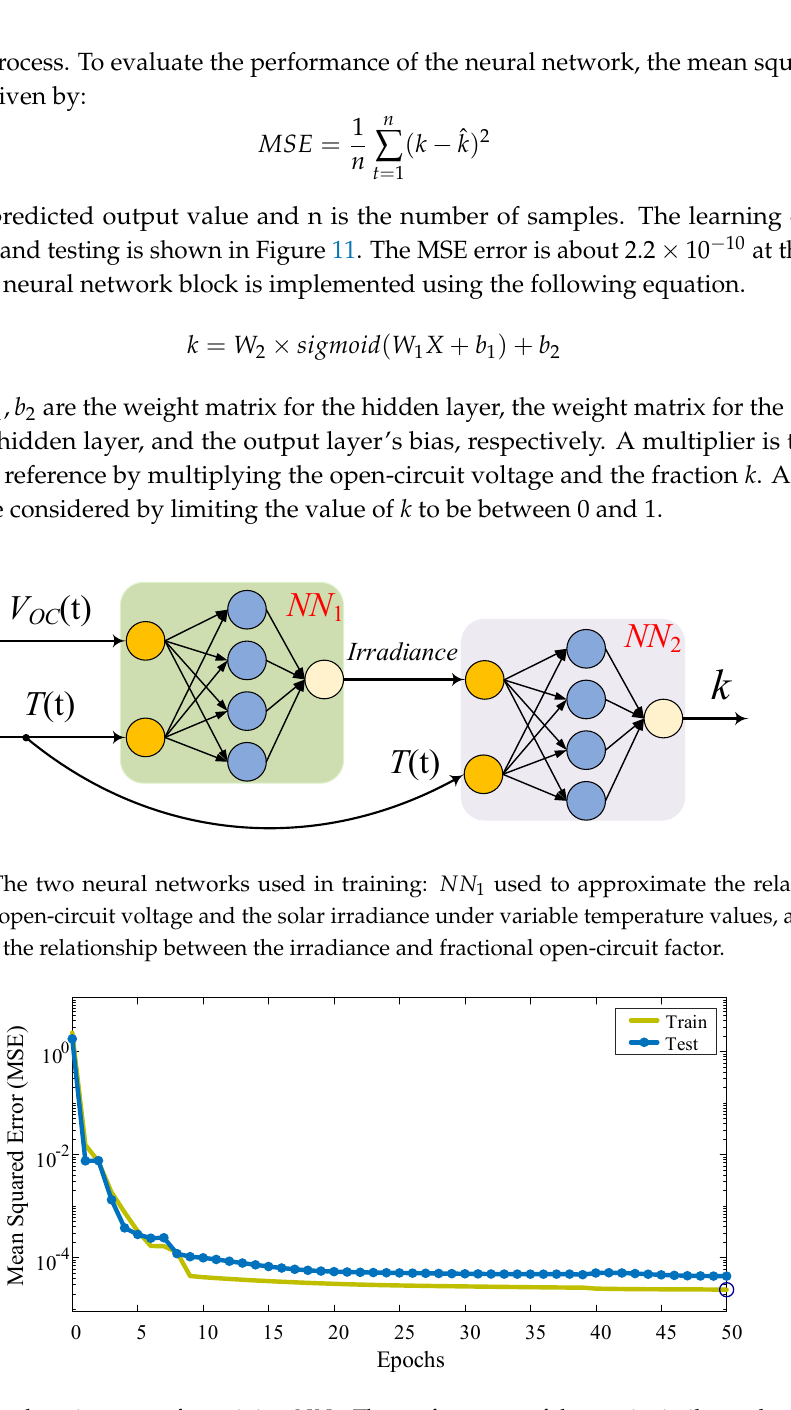
Figure 11. The learning curve for training NN 1 . The performance of the test is similar to the